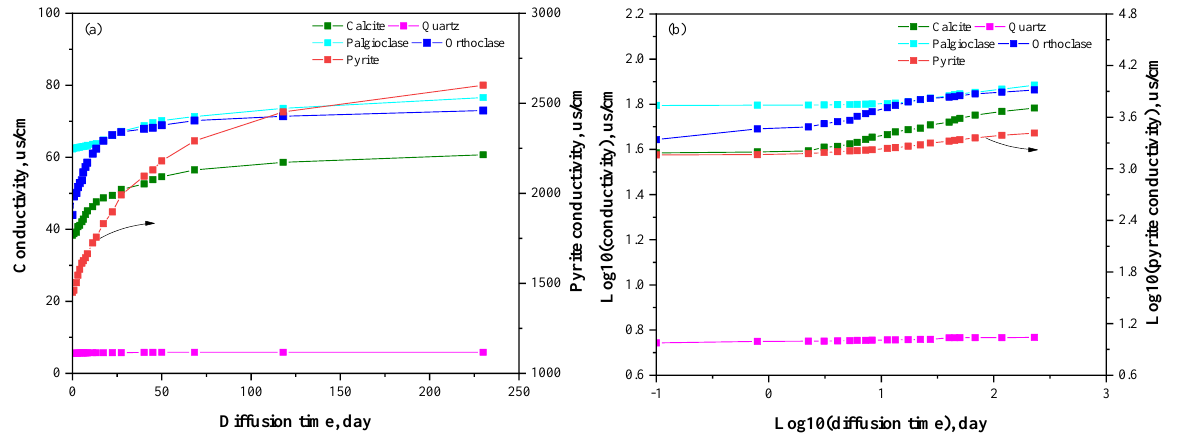
Figure 9. Ion diffusion curves of single non – clay minerasl: ( a ) conductivity over time and ( b ) double logarithm of conductivity with time.